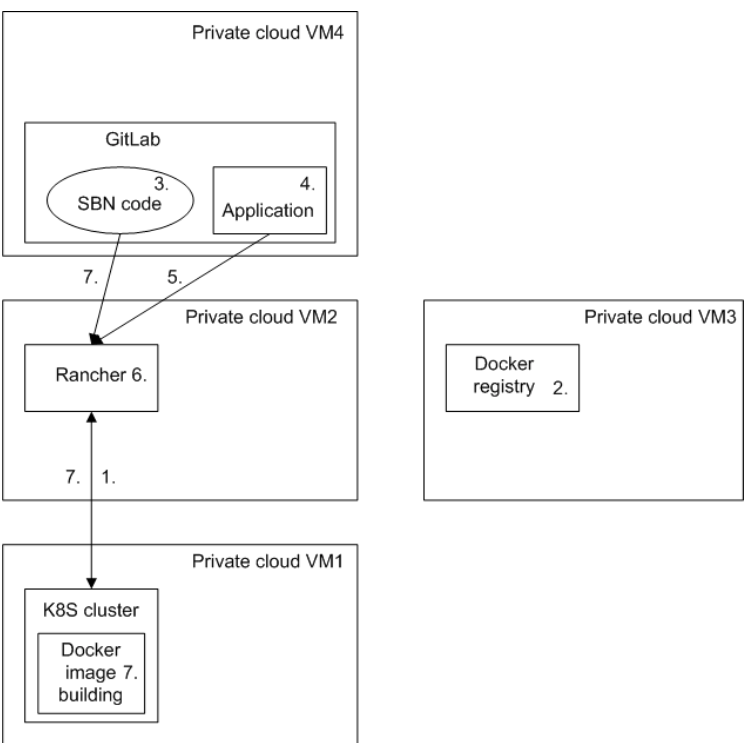
Figure A2. Architecture design for continuous integration/delivery with Rancher pipelines.